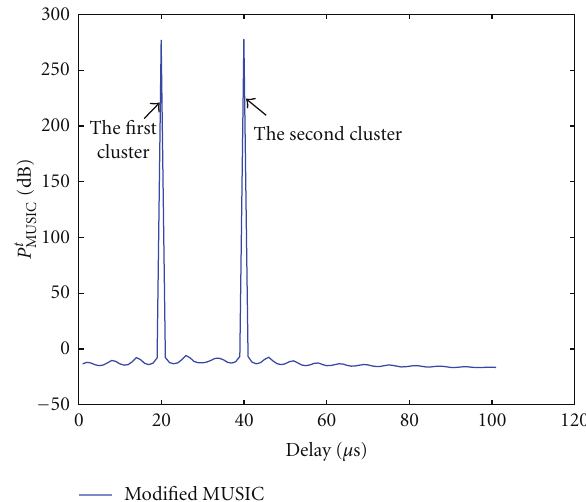
Figure 2: Delay clusters estimation using our algorithm.